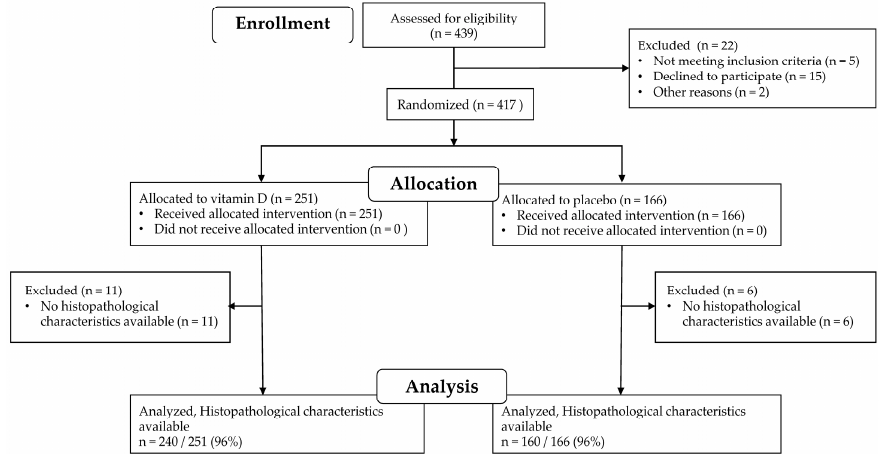
Figure 1. Patient flow through the AMATERASU trial and this post-hoc analysis.